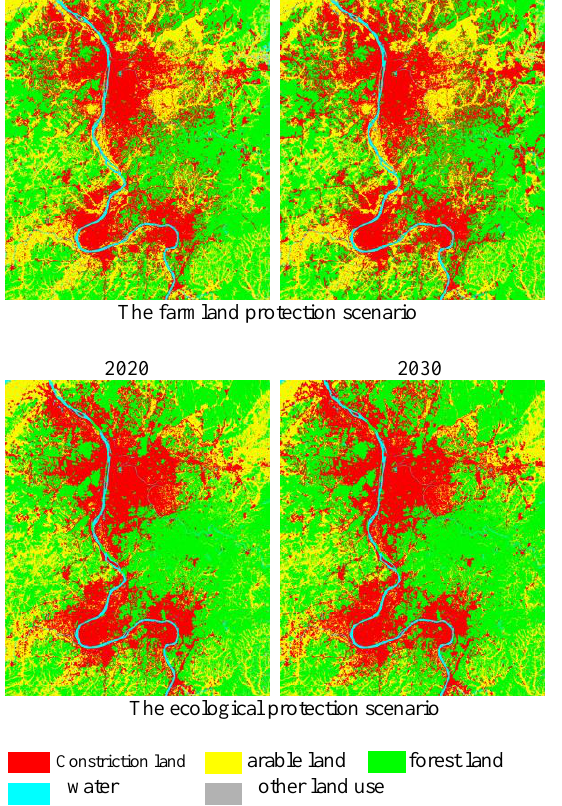
Figure 4. Land use spatial optimization allocation in 2020 and 2030 under three different